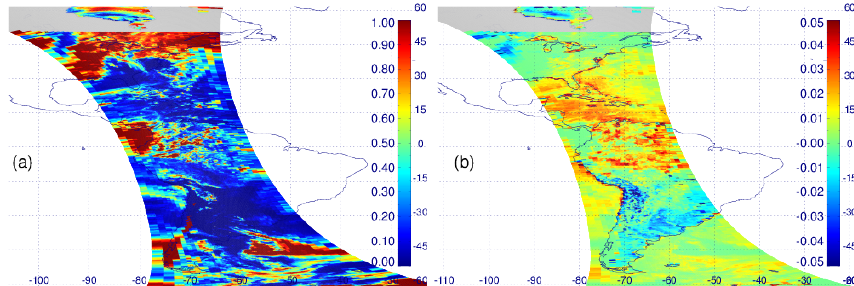
Figure 5. (a) RRS-retrieved ECF computed with geometry-dependent LERs and (b) the difference between the ECFs computed with geometry-dependent and climatological LERs for OMI orbit 12414 of 14 November 2006. ECF data correspond to LER shown in Fig.